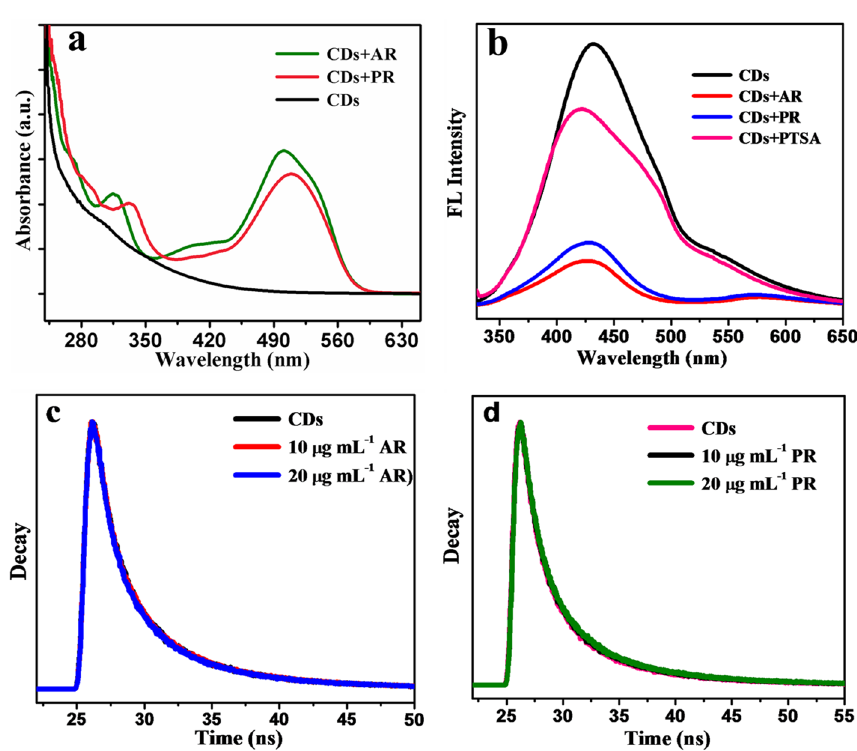
Figure 4. Interpretation of mechanism of quenching through; ( a ) Absorption spectrum ( b ) fluorescence spectrum; life time spectrum with AR dye ( c ) and with PR dyes ( d